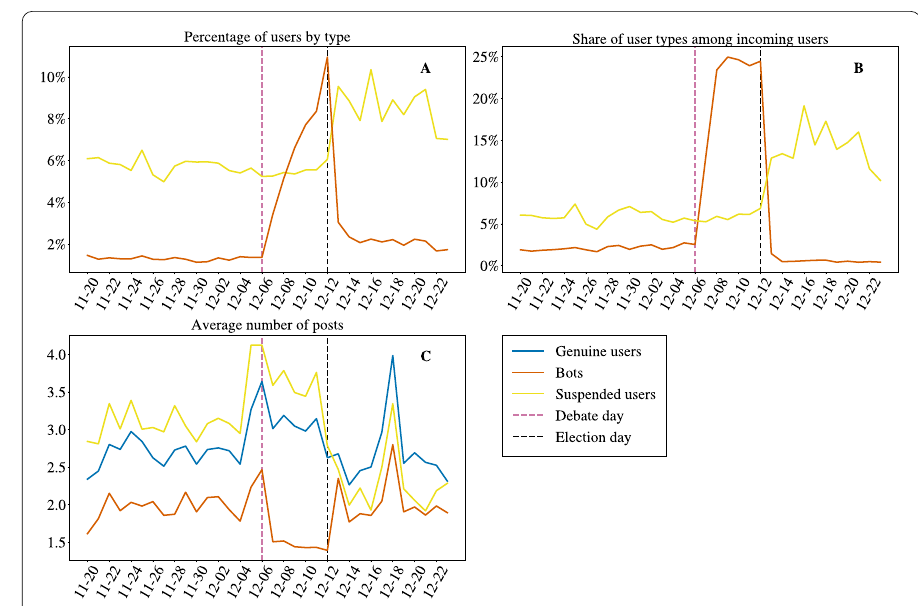
Figure 3 Presence of daily active bots and suspended users in the discussion over time. For users labeled as bots (with a score higher than 0.43) that have not been suspended, there is a change after the debate of the 6th of November (panel A ), with new bots coming into the discussion (panel B ). The new bots seem less active than the old ones (panel C ). The percentage of active bots among genuine users becomes as high as 10%. Among the removed users, the changes happen after the 12th of December (election day), with new suspended users entering the discussion while being less active on average